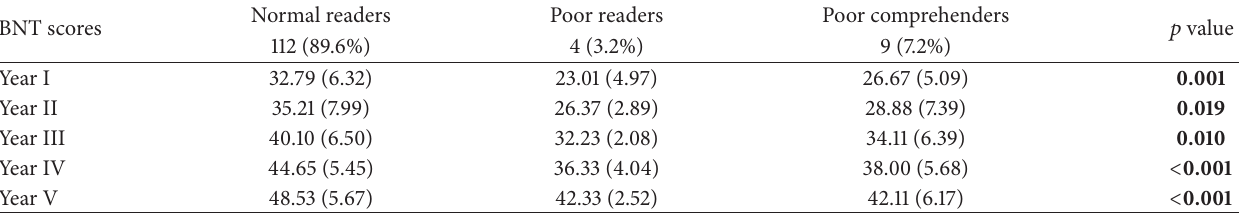
Table 6: Boston Naming Test scores obtained by the three groups: “normal readers,” “poor readers,” and “poor comprehenders” (one-way ANOVA test, Bonferroni post hoc test).